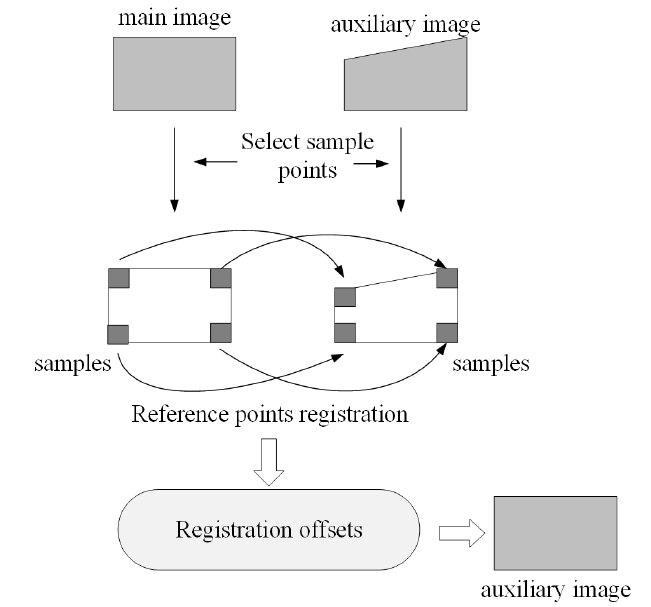
Figure 7. Image registration